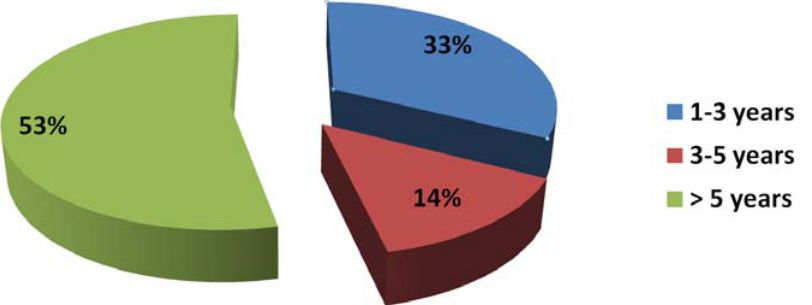
Figure 6. Distribution of workers based on their experience in the mining industry.